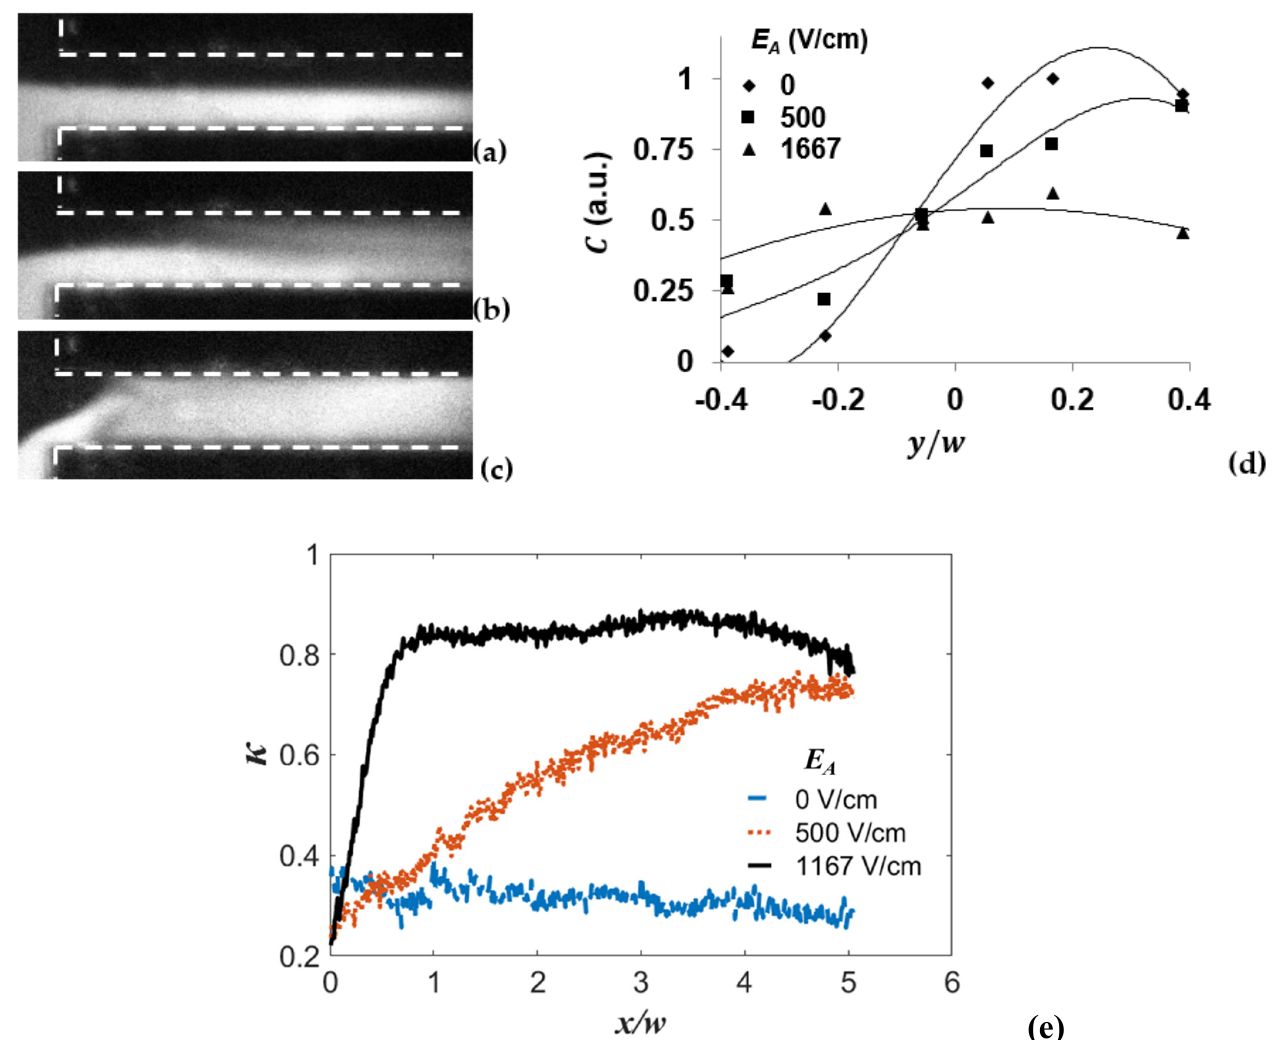
Figure 9. Visualization and comparison of mixing result in microchannels with various E A . Here, f AC = 10 kHz and γ = 10. ( a ) 0; ( b ) 500 V/cm; ( c ) 1167 V/cm; and ( d ) comparison of concentration profile in transverse direction at x / w = 3 from the channel entrance with different AC voltages. ( e ) Mixing index varying along streamwise direction at different E A